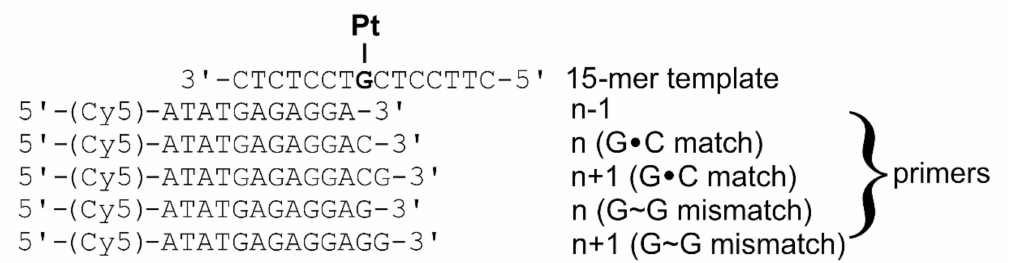
Figure 4. Sequences of 15-mer template and primers n − 1, n, and n + 1. The bold letter G in the template indicates the AMD